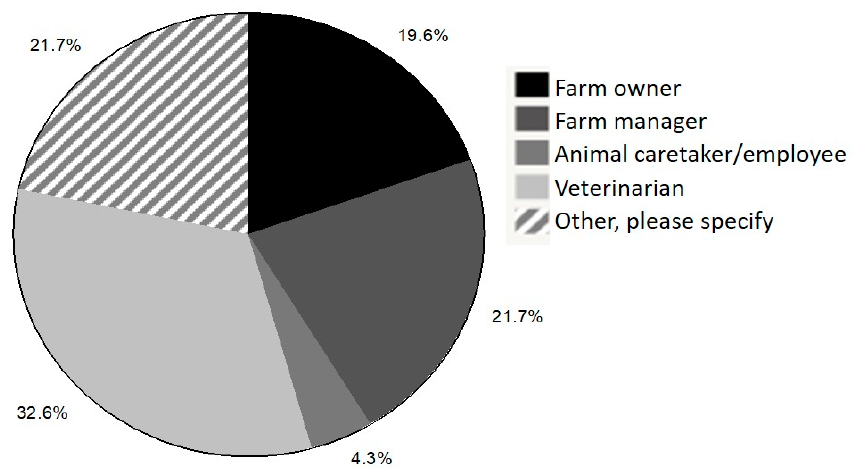
Figure 1. Responses of survey respondents who indicated that they were not the primary party responsible for making euthanasia decisions and were asked to specify the role of the individual who makes most of the euthanasia decisions.